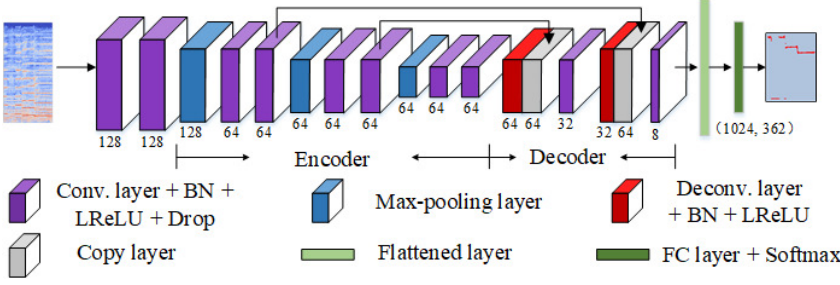
Figure 7. The architecture of the proposed encoder-decoder network for vocal melody